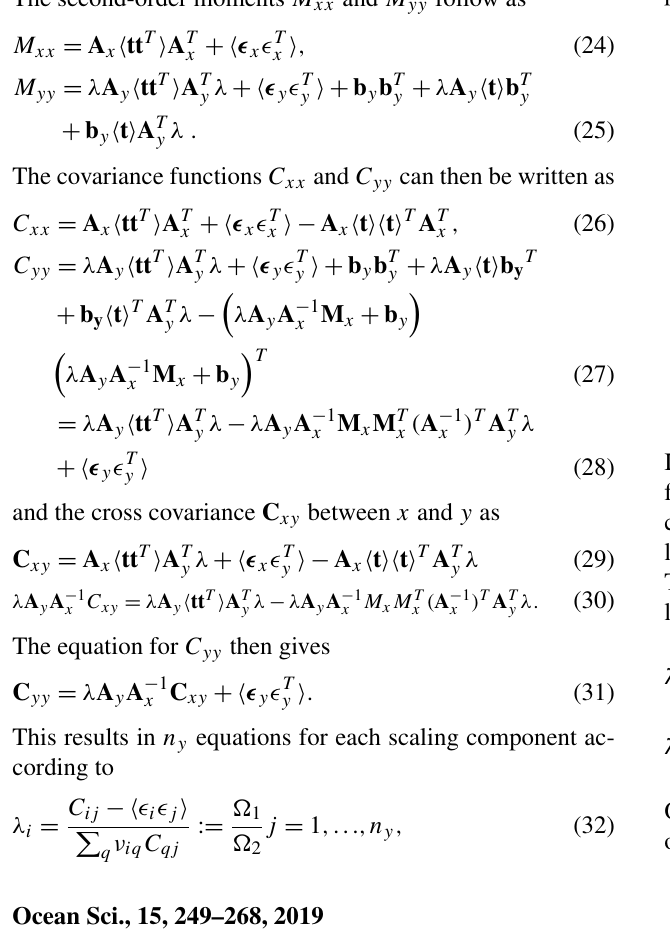
matrix. Apart from a possible bias, the vector of data sources y may be also affected by systematic calibration errors rep- resented by the diagonal matrix λ